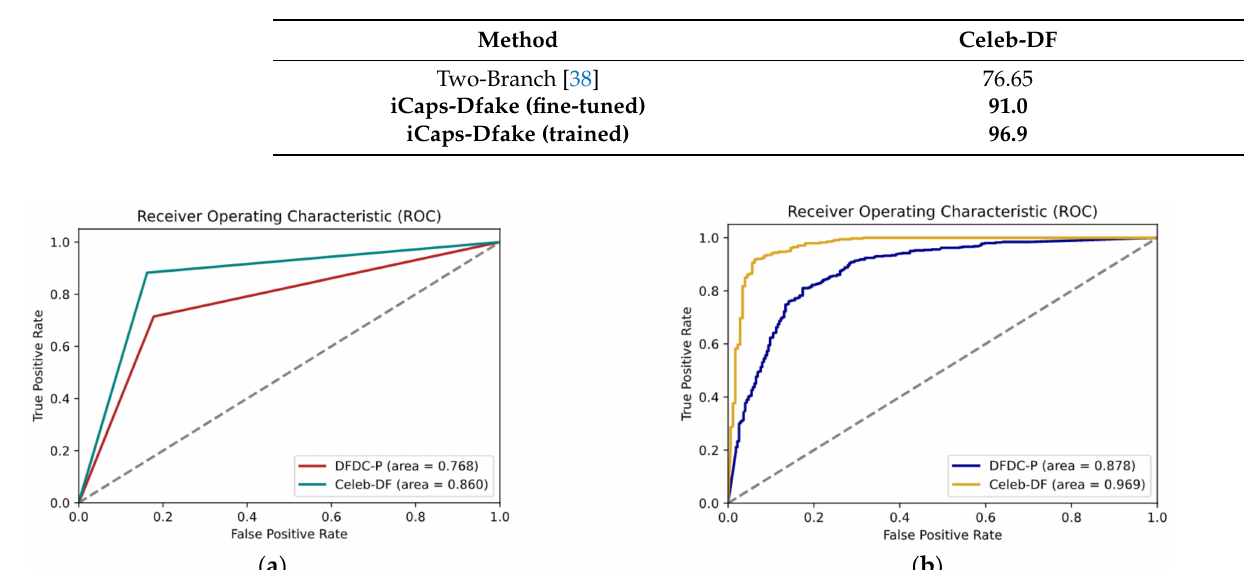
Figure 11. ROC curves for both the DFDC-P and Celeb-DF datasets at frame and video levels using ( a ) frame level and ( b ) video level.